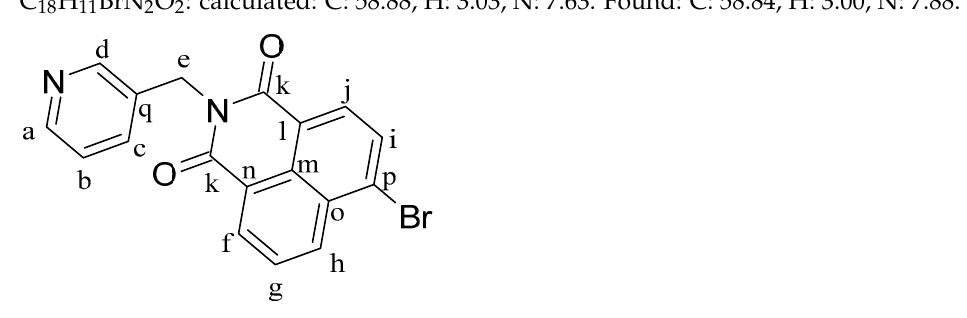
4-Bromo-1,8-naphthalenic anhydride (0.2 g, 0.73 mmol) and 3-picolylamine (0.093 g, 0.86 mmol) were dissolved in 15 mL of ethanol at 80 °C and heated for 24 h. After 1 h of reaction, a precipitate formed. The mixture was cooled to room temperature and the white solid was separated by filtration and dried under vacuum, obtaining L1Br (Figure 10). Yield : 91%. 1 H-NMR ( δ , ppm, 400 MHz, CDCl 3 ): 8.87 (d, J = 2.4 Hz, 1H, H d ), 8.70 (dd, J = 7.3 Hz, J’ = 1.2 Hz, 1H, H i ), 8.62 (dd, J = 8.5 Hz, J’ = 1.2 Hz, 1H, H j ), 8.55 (dd, J = 5.0 Hz, J’ =